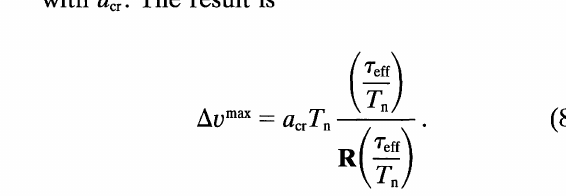
FIGURE 4 SRS plot of Fig. 3 drawn to higher resolution on the x axis. Insets show pulse durations in comparison to system free vibration time period for Tell/Tn = 0.5 and